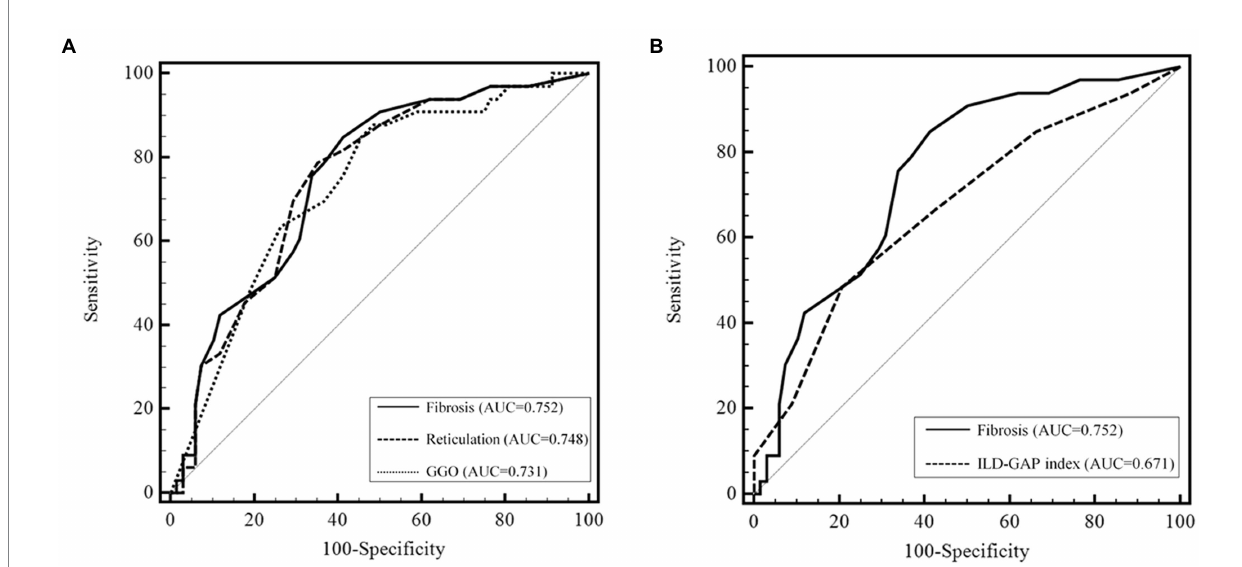
FIGURE 1 Predictive performance of CT scores for the 5 year mortality in patients with fibrotic HP. (A) Comparison of the predicting performance of the 5 year mortality among the CT scores. The area under the ROC curve was higher for the fibrosis score than for reticulation and GGO scores; however, the difference was not statistically significant (fibrosis, AUC = 0.752, 95% CI 0.656–0.833, p < 0.001; reticulation, AUC = 0.748, 95% CI 0.651–0.829, p < 0.001; GGO, AUC = 0.731, 95% CI 0.634–0.815, p < 0.001) ( p = 0.758 and p = 0.697 between reticulation and fibrosis, GGO and fibrosis, respectively). (B) Comparison of the predicting performance of the 5 year mortality between fibrosis score and ILD-GAP index. CT, computed tomography. AUC, area under the curve. GGO, ground glass